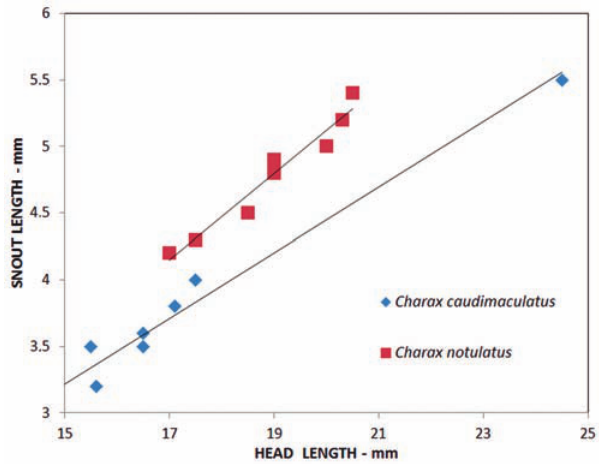
Fig. 5. Snout length as a function of head length for Charax caudimaculatus and C. notulatus